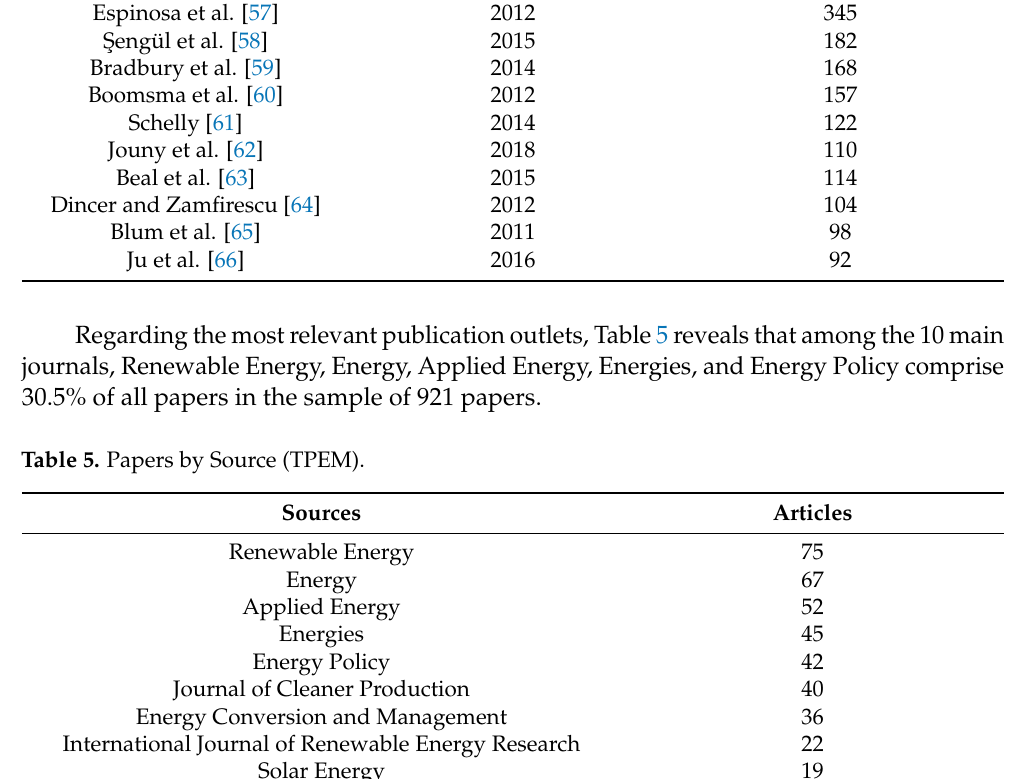
Figure 6. Annual Scientific Production (LCOE).